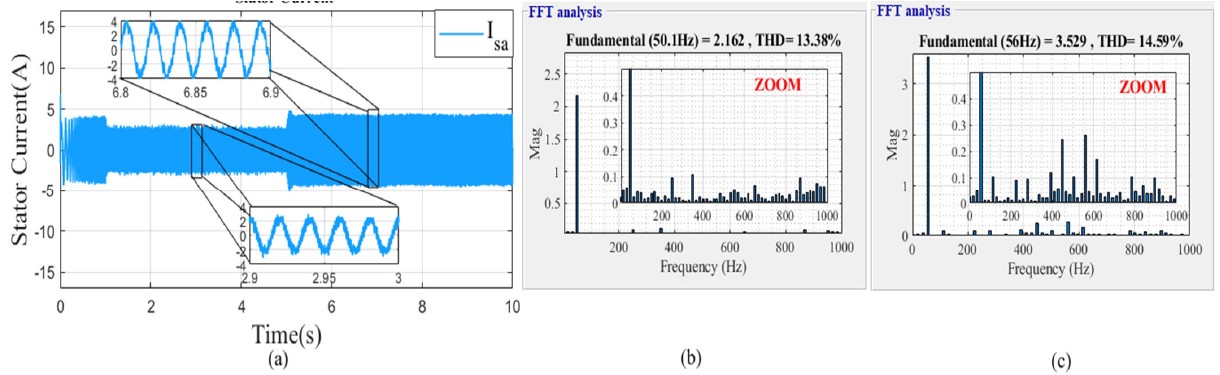
Figure 34. Performance with Ball bearing defect of IM with DTC control: ( a ) Stator current and ( b ) THD at no ‐ load and ( c ) THD with load (5 Nm).